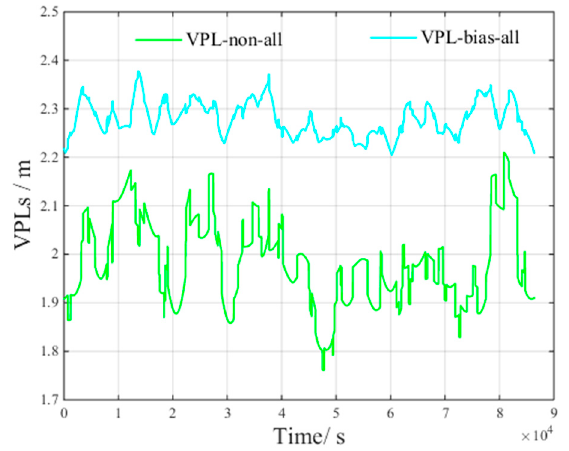
Figure 10. VPL of all visible satellites under non-nominal troposphere.